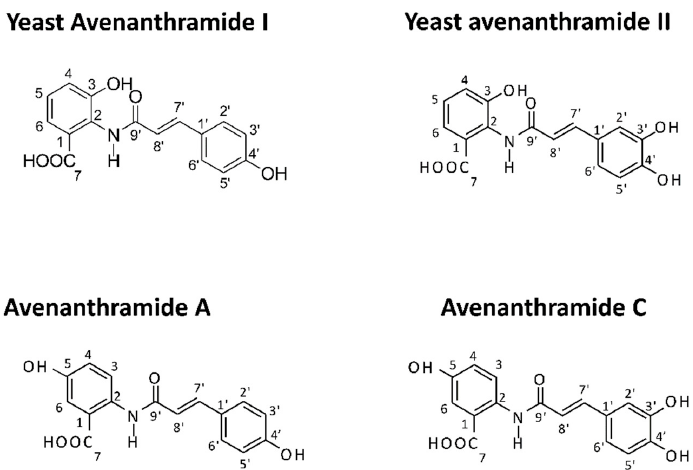
Figure 1. Molecular structure of yeast (YAvns) and oat avenanthramides. The structure of YAvnI and YAvnII differ from Avenathramide A (Avn-A) and Avenanthramide C (Avn-C) respectively in the position of the hydroxyl group relative to the amide bond.